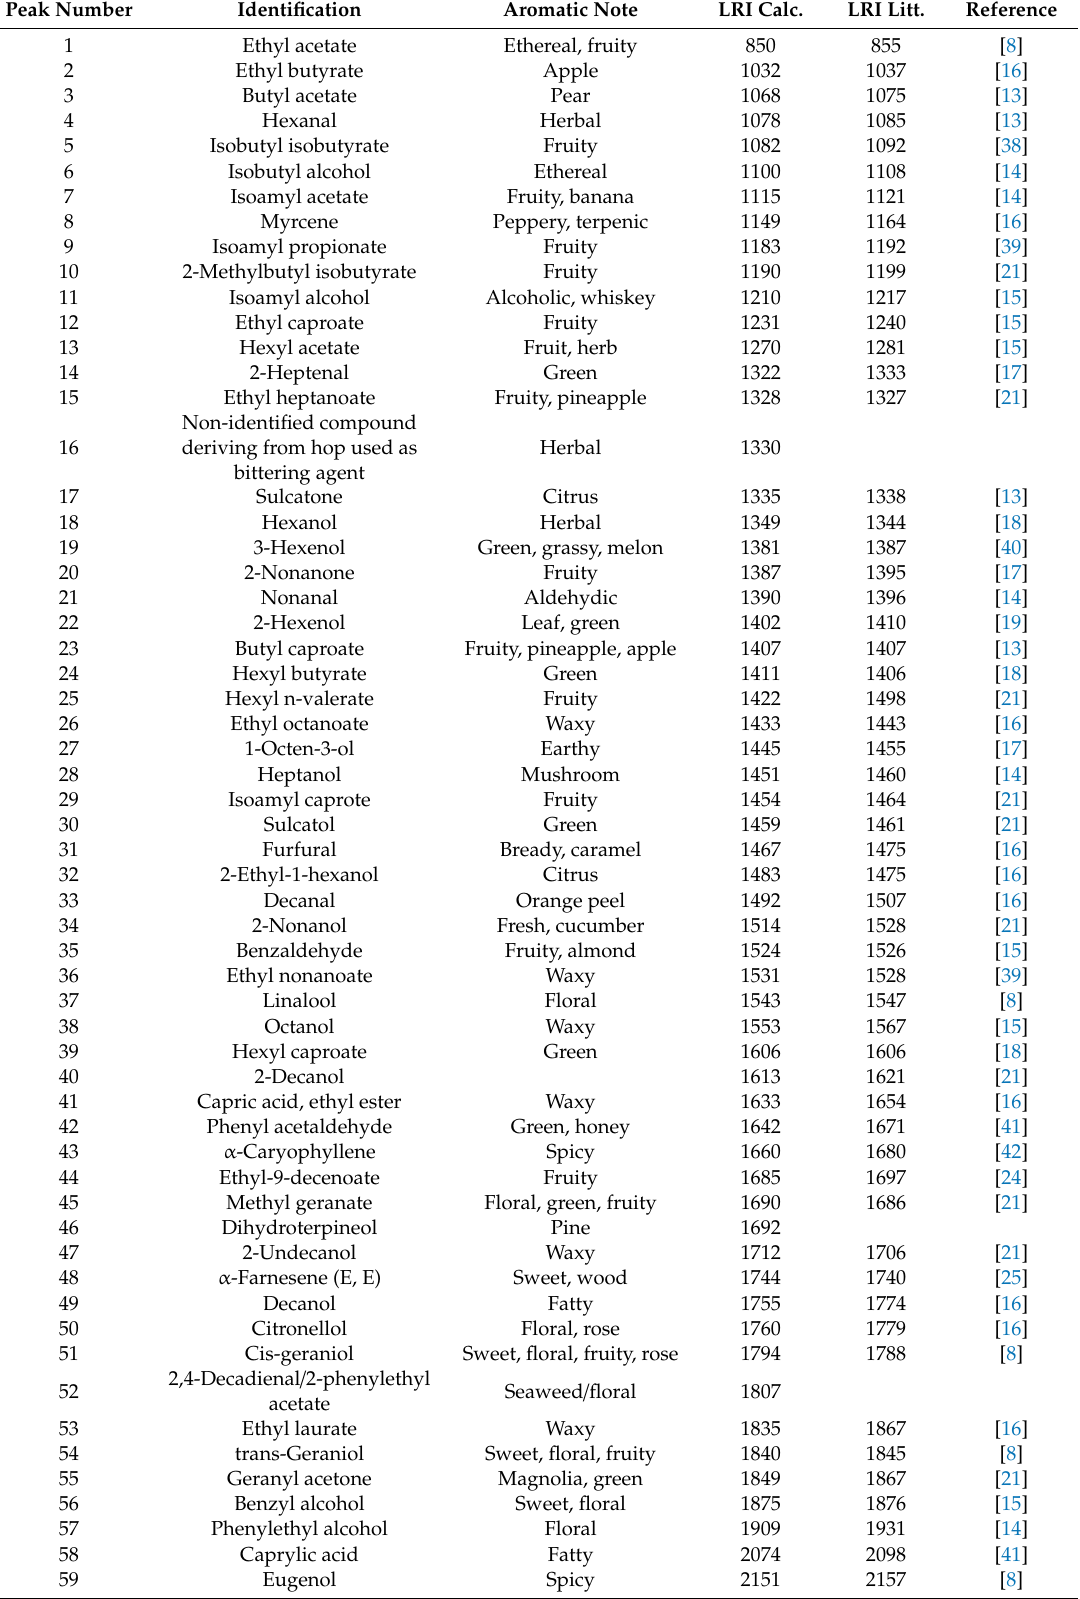
Table 2. Volatile compounds characteristic of beer samples. For each volatile compound aromatic note, calculated and tabulated LRIs and references are